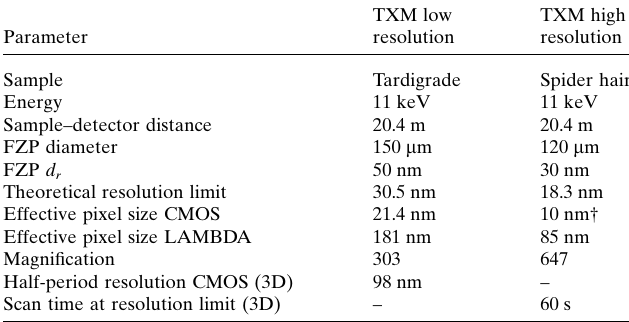
Table 1 Parameters of the TXM (Zernike phase contrast) measurements for the low-resolution and high-resolution setups.